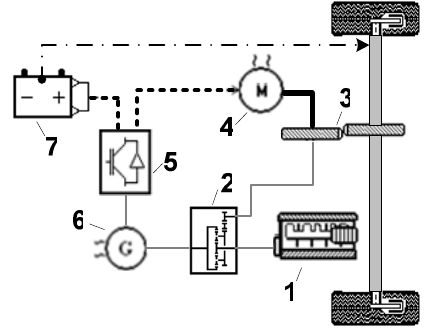
Fig 3. Start and movement at low speed to Figs 3–6: 1 – internal combustion engine; 2 – planetary gear; 3 – reduc- tion gear; 4 – electric motor; 5 – commutator; 6 – generator; 7 – battery; on Figs: solid heavy lines indicate the way of torque, dash heavy lines indicate electric power way, dashdot lines-total power